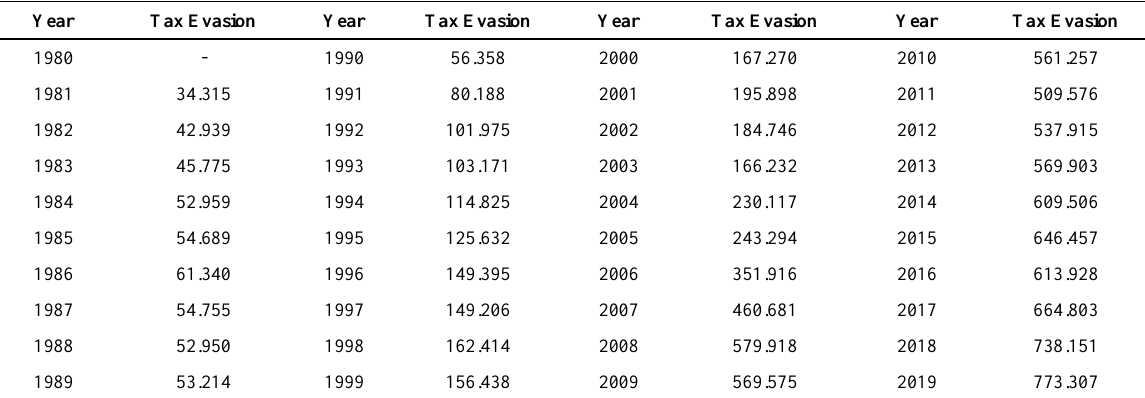
Table 4. The estimated tax evasion size, Million